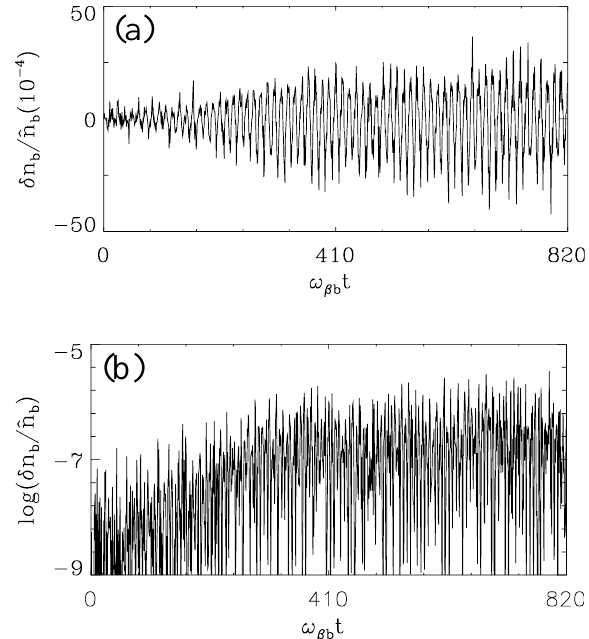
FIG. 7. Linear and nonlinear phases of the electron-proton instability.